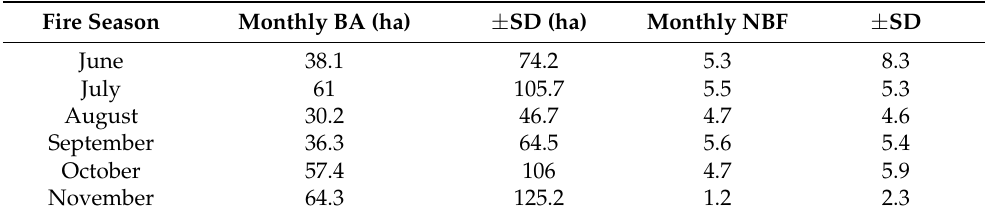
Table 5. Monthly average BA ( ± SD) (ha) and monthly average NBF (number of fires; ≥ 5 ha) ( ± SD) in Lebanon during the fire season for the period 2001–2020. SD: standard deviation.